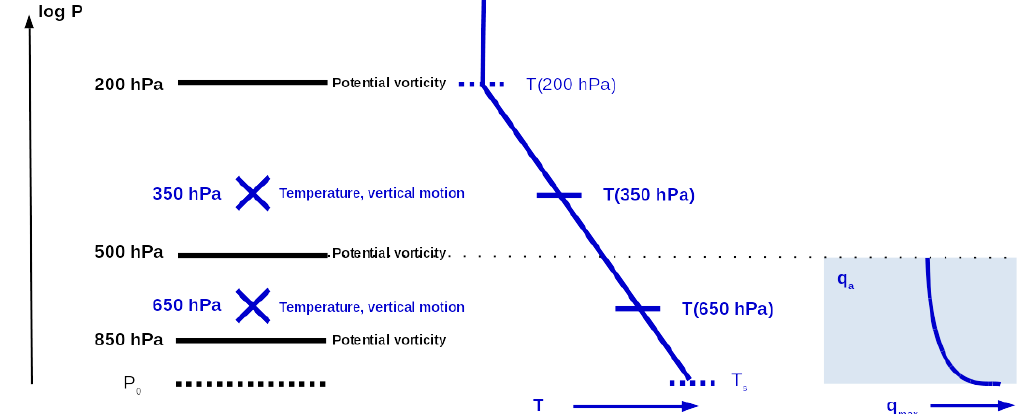
Figure 1. Schematic representation of the atmosphere in ECBilt. The three levels for the vorticity equation are 200, 500 and 850hPa. The temperature is effectively computed for 350 and 650hPa, and then linearly interpolated on a log scale to any other pressure level. The saturation profile in the moist layer (below 500hPa) is computed from tabulated